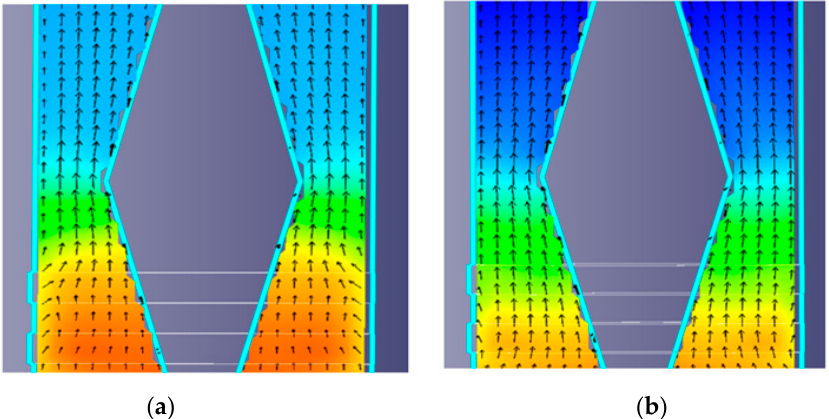
Figure 8. Distribution of air flow velocity and pressure in a vertical channel of variable cross section at ( a )— 𝑉 (cid:3017) = 5 m/s; ( b )— 𝑉 (cid:3017) = 9 m/s.